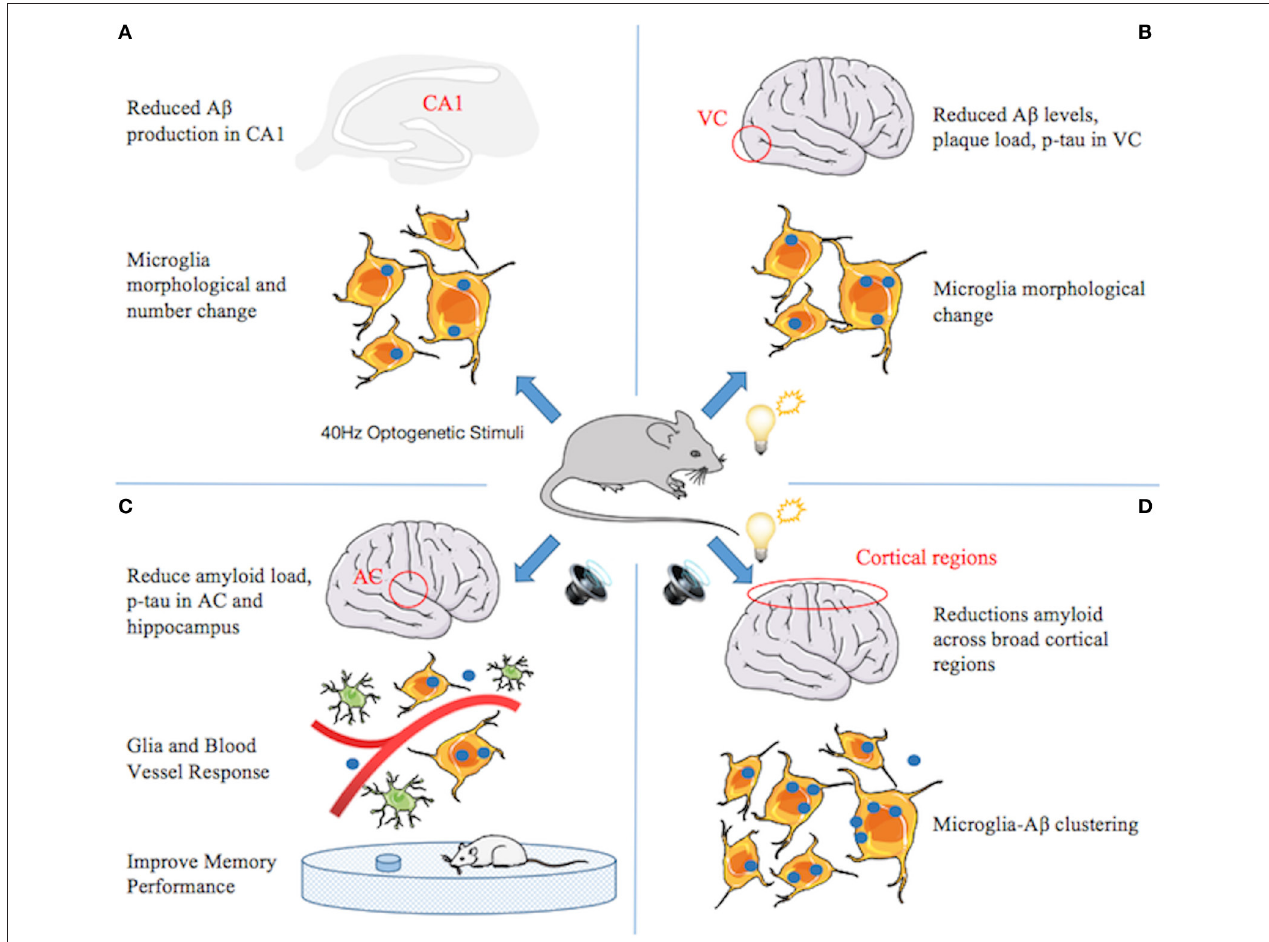
FIGURE 2 | A series of studies from Li-Huei Tsai indicating that gamma stimulations ameliorate pathology and cognitive impairment in Alzheimer’s disease (AD). (A) Gamma induced by optogenetic stimuli reduced amyloid beta (A β ) production in CA1, increased number and cell body diameter of microglia, and reduced the process length of microglia compared with the control group, indicating an engulfing state of microglia. The percentage of microglia co-localized with A β in the cell body increased, suggesting that gamma stimulation triggers microglia to increase A β uptake. (B) Gamma induced by light flicker reduces A β levels and plaque load in the visual cortex (VC). Microglia changes similar to (A) , except that the number does not change. (C) In 5xFAD mice, 40-Hz auditory stimulation improves memory performance and reduces amyloid load and tau phosphorylation and seeding in the auditory cortex (AC) and hippocampus. The changes of microglia similar to (A) and the number of astrocytes increased. Furthermore, blood vessel diameter increased. (D) Combined auditory and visual stimulation induces a clustering phenotype response by microglia and reduces amyloid load across broad cortical